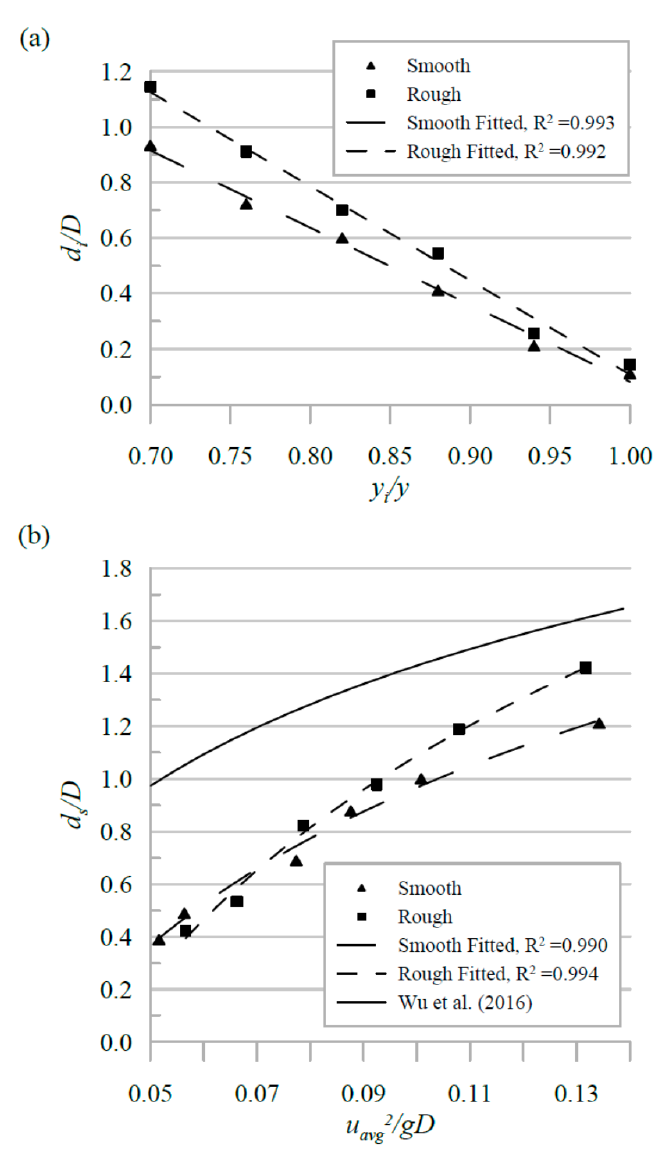
Figure 10. ( a ) Additional scour induced by the ice cover, and ( b ) the relationship between nondimen- sionalized maximum scour depth ( d s ) and pier Froude